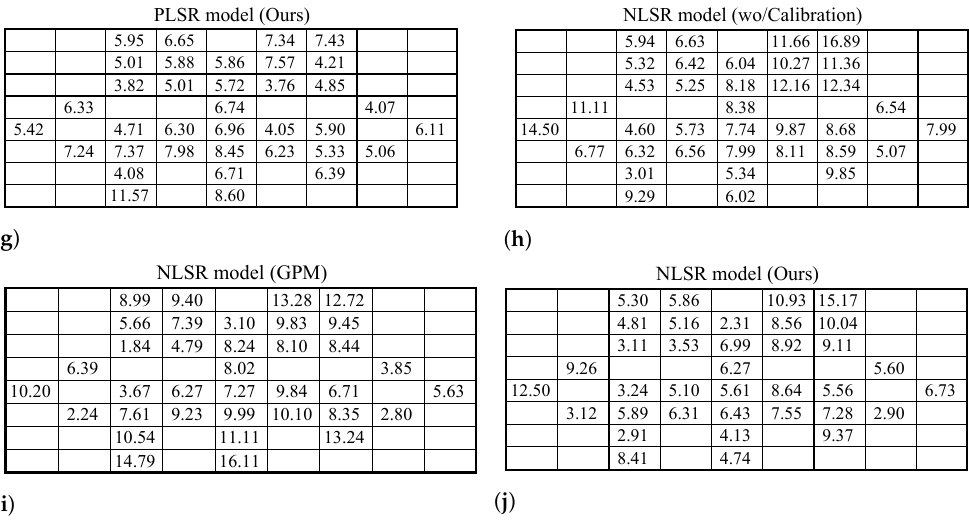
Figure 5. Absolute mean error (degree) on different gaze zones: ( a ) gaze zone partition; ( b ) GPR model without calibration; ( c ) GPR model with GPM method; ( d ) GPR model with the proposed method; ( e ) PLSR model without calibration; ( f ) PLSR model with GPM method; ( g ) PLSR model with the proposed method; ( h ) NLSR model without calibration; ( i ) NLSR model with GPM method; and ( j ) NLSR model with the proposed method. Compared with the related pre-trained models without calibration, the pre-trained models with GPM method or the proposed method have reduced the estimation error on gaze zones.